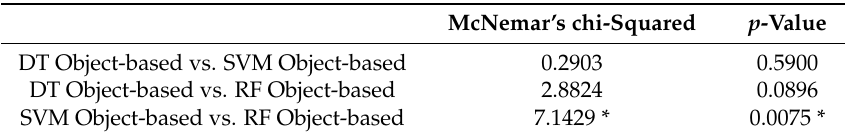
Table 5. Statistically significant comparison between three object-based machine learning algorithms.